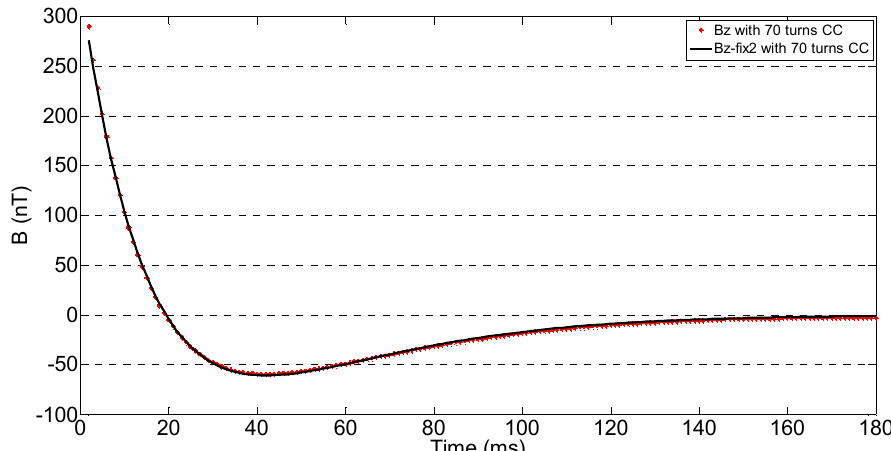
Figure 5. Curve fittings of the residual magnetic field in z direction with 70 turns CC. ‘ + ’ type of the red curve is experimental data after t s = 2 ms; black curve B z-fix 2 is the fitting curve.